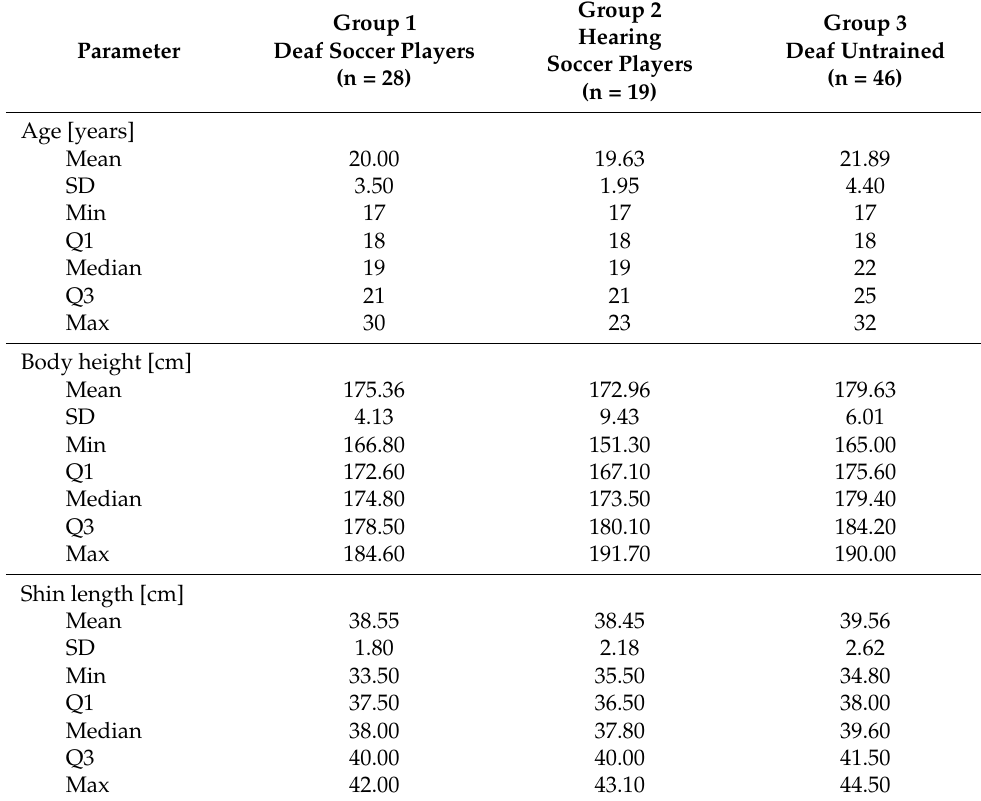
Table 1. Characteristics of the patients